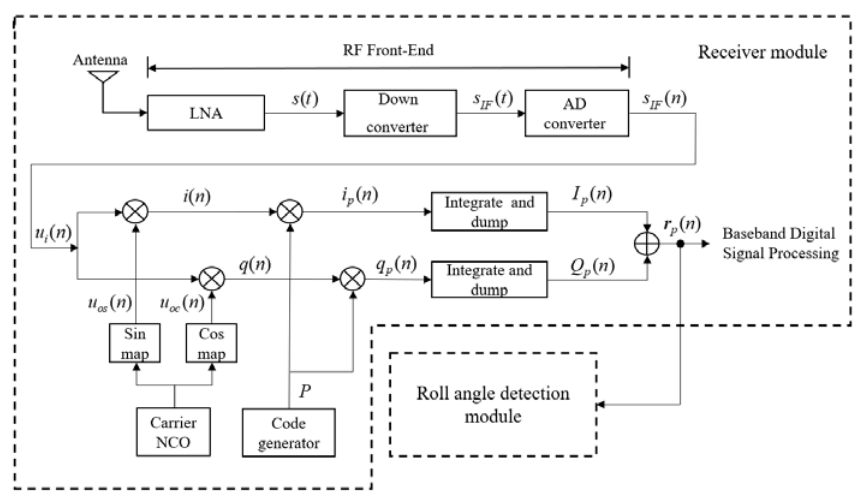
Figure 5. The block diagram of a GPS receiver with a roll angle detection module.